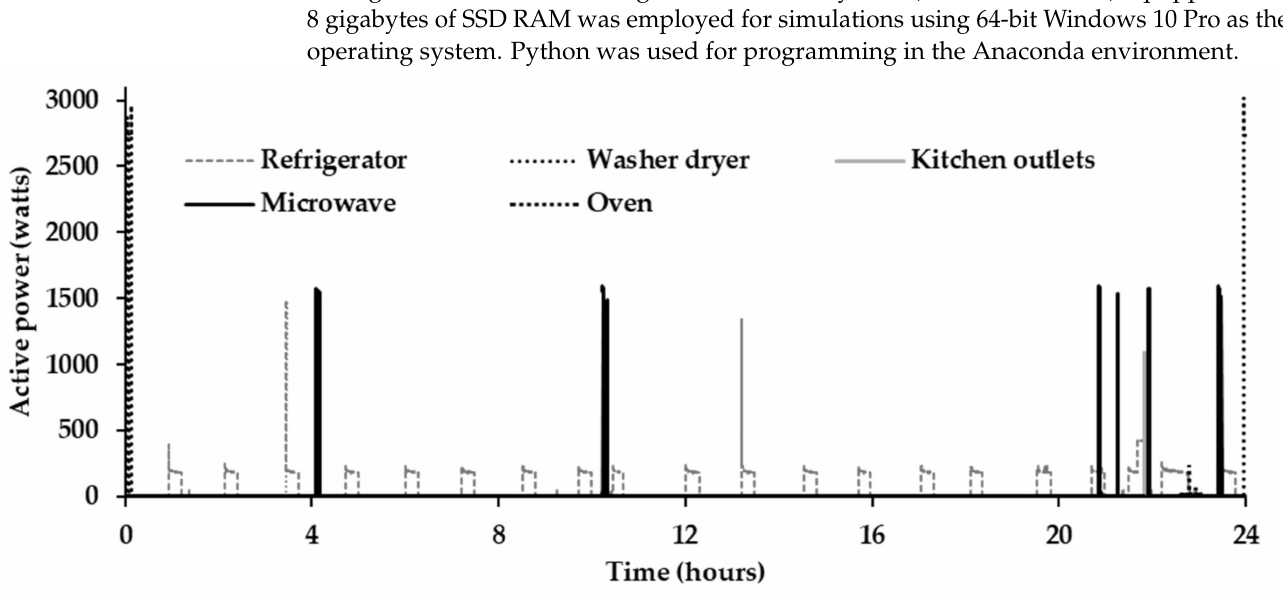
Figure 4. Actual ALDs for testing data